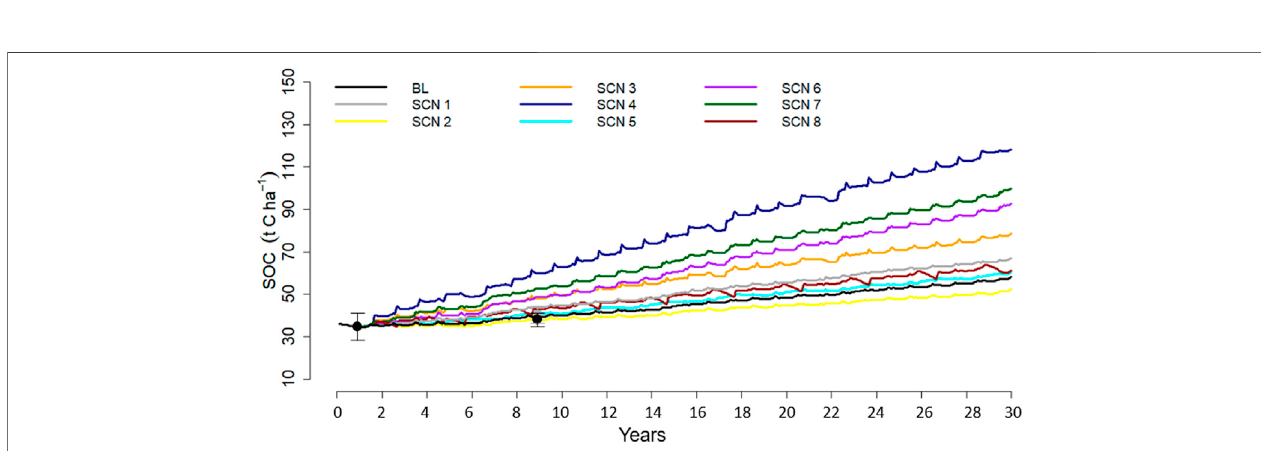
FIGURE 7 | The mitigation potential for SOC under different scenarios in the long-term test sites Huesca (Spain) for the period of 2010 – 2039 at 0 – 30 cm depth usingECOSSEmodeling.BL:BaselineassociatedwithbarleycerealrotationswithRT.SCN1:NT,SCN2:Barley-fallowrotations,SCN3:sheepcompost10 t ha − 1 yr − 1